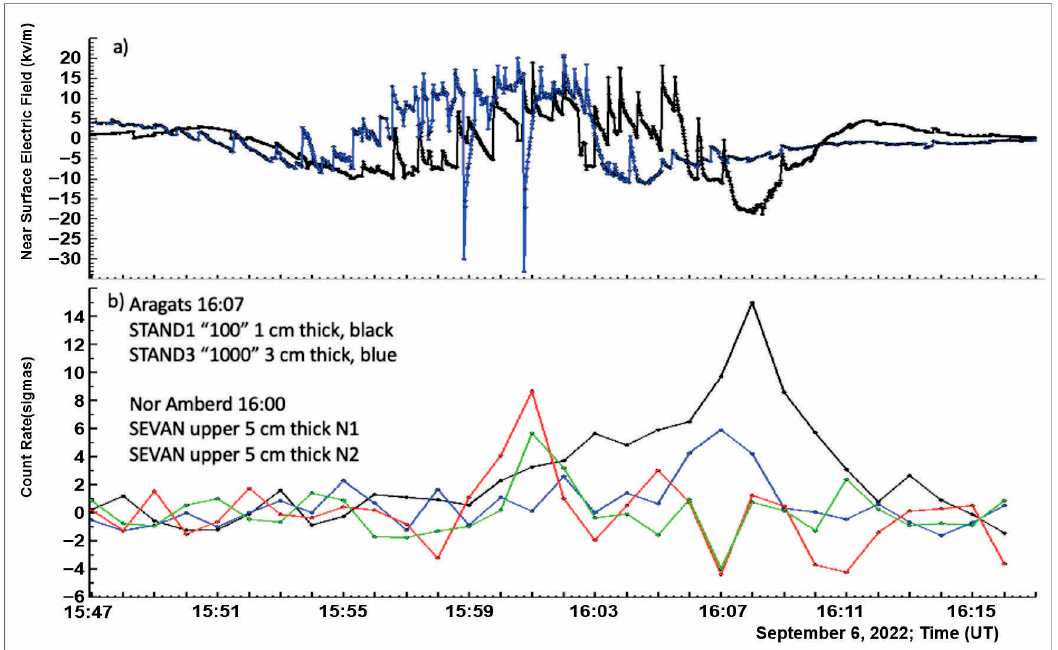
Figure 9. ( a ) Disturbances of the NSEF measured on Aragats (black) and in Nor Amberd (blue); ( b ) 1-minute time series of count rates of 1 cm and 3 cm thick (both 1 m 2 area) plastic scintillators on Aragats (black and blue) and 2 identical 5 cm thick and 1 m 2 area plastic scintillators in Nor Amberd (red and green).